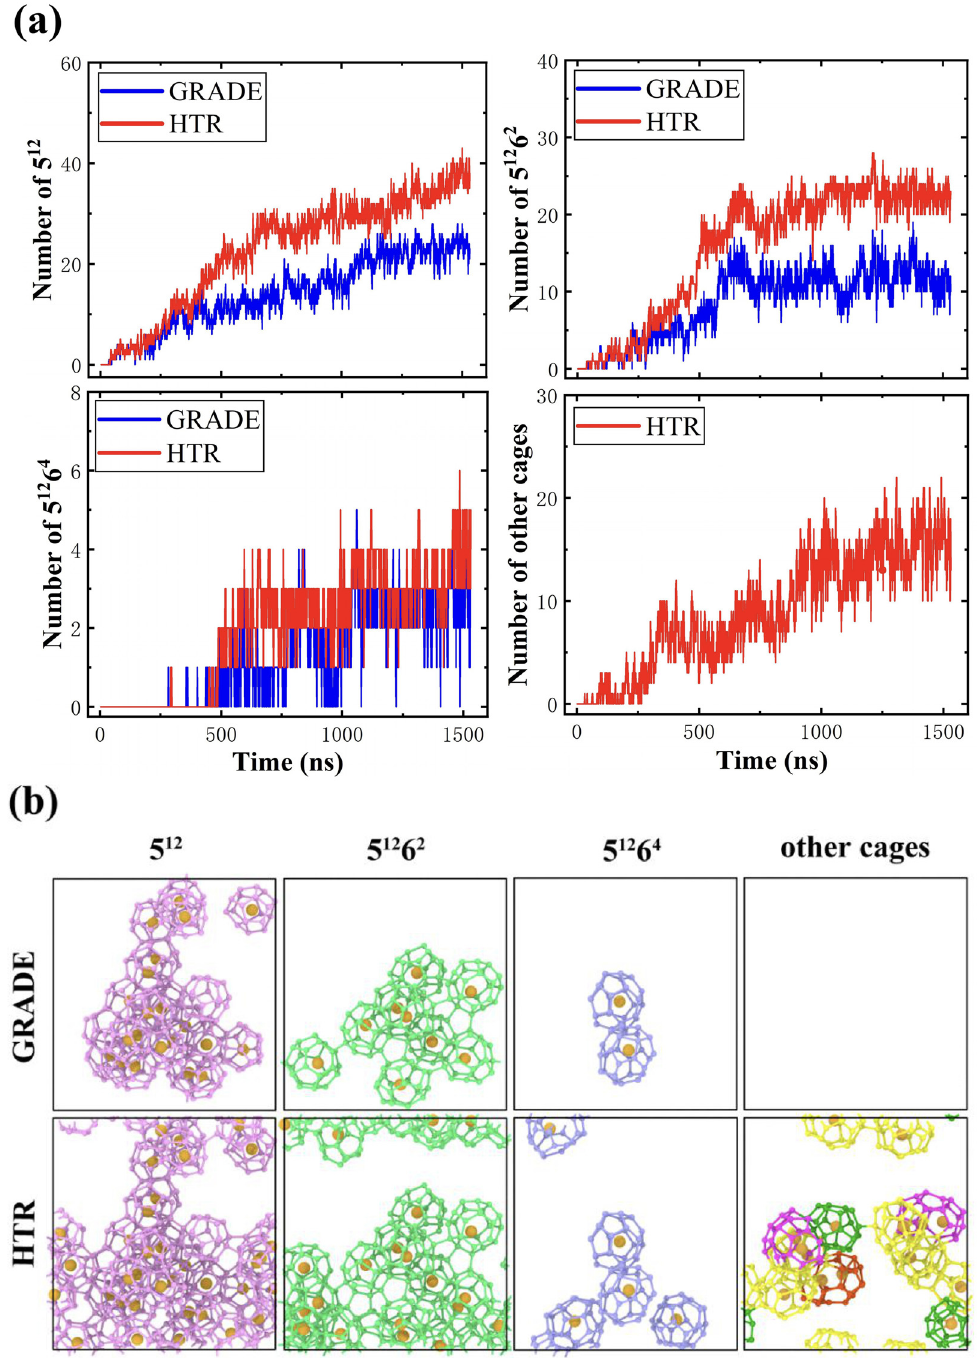
Figure 8: ( a ) Numbers of 5 12 , 5 12 6 2 , 5 12 6 4 , and other cages identi fi ed by the HTR algorithm and the GRADE algorithm in the entire trajectory. ( b ) A snapshot of each cage identi fi ed by HTR and GRADE at 1,000